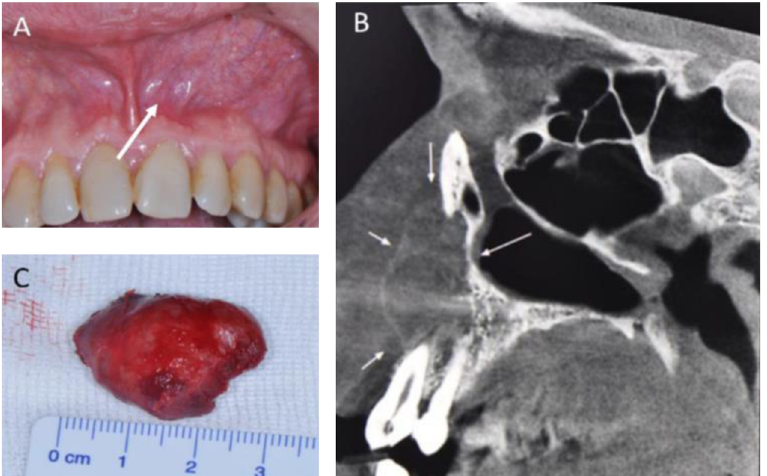
Fig. 2. (A) Intraoral view showing the vestibular arch caused by the lesion. (B) Parasagittal section of the cone-beam computed tomography showing vestibular extension and compartments of the lesion. (C) Image of the